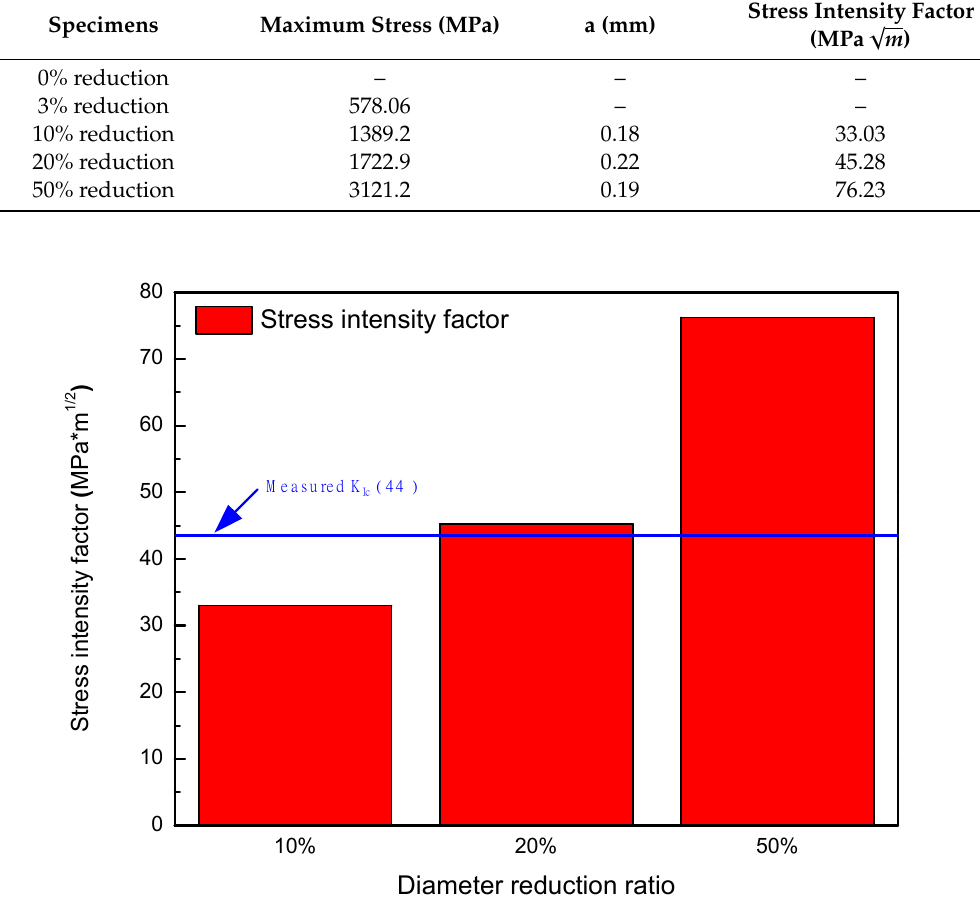
Figure 15. Stress intensity factors calculated for cases of the corroded tensile specimens according to diameter reduction diameter reduction ratios.